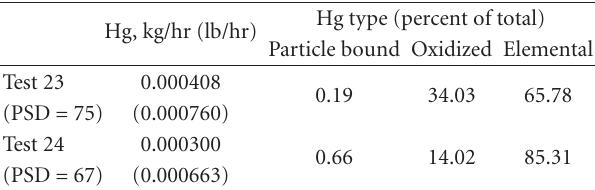
Table 7: Hg emissions through the